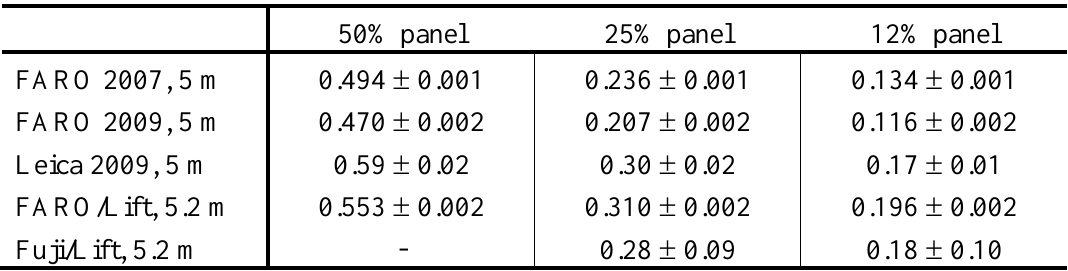
Table 1. Comparison of calibrated backscatter reflectance at about a 5 m distance with average errors (standard deviations). The average errors for the profiler mode experiments (FARO and Leica 2009) are estimated from stationary measurements for the same target. The 50% panel was used as reference for the Fuji measurements (because the 99% panel was poorly visible in the